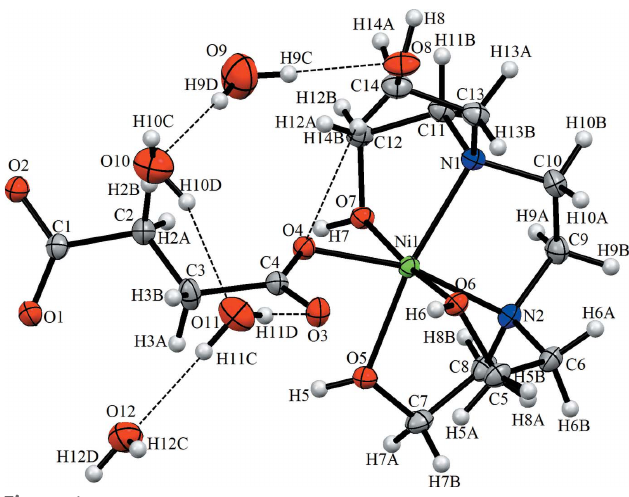
Figure 1 The molecular structure of the title compound, showing the atom labelling. Displacement ellipsoids are drawn at the 20% probability level.